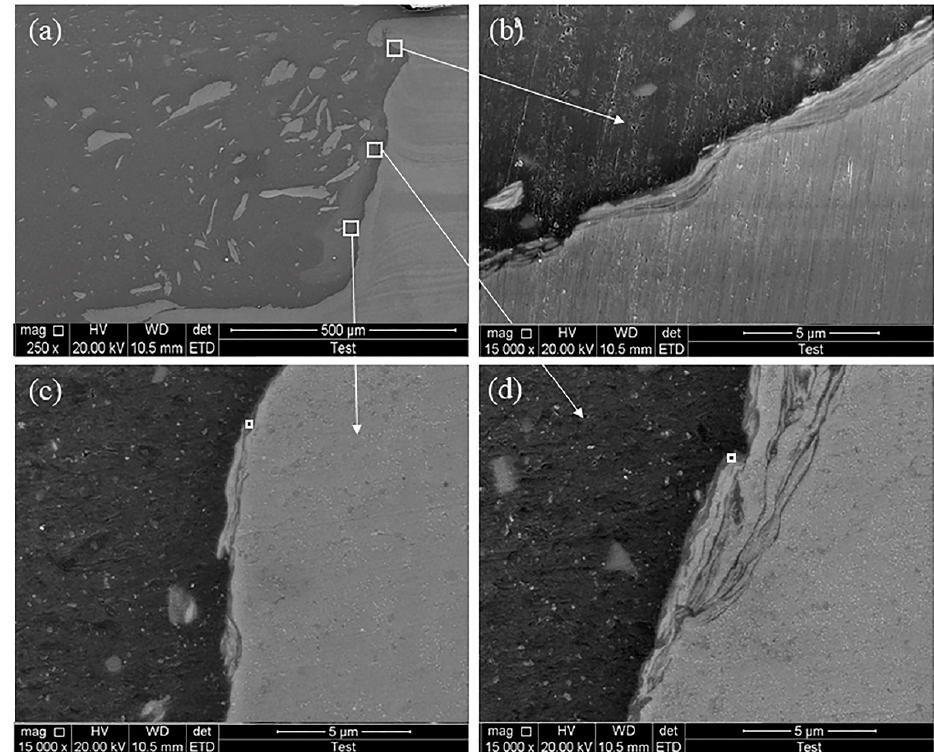
Figure 6. SEM image of the HRS-FSW interface and the EDS measuring position under a high tool offset. ( a ) Low- magnification SEM picture, ( b ) SEM Al-Fe interface picture at the top and EDS point scan position, ( c ) SEM Al-Fe interface picture in the middle, and ( d ) SEM Al-Fe interface picture at the bottom.